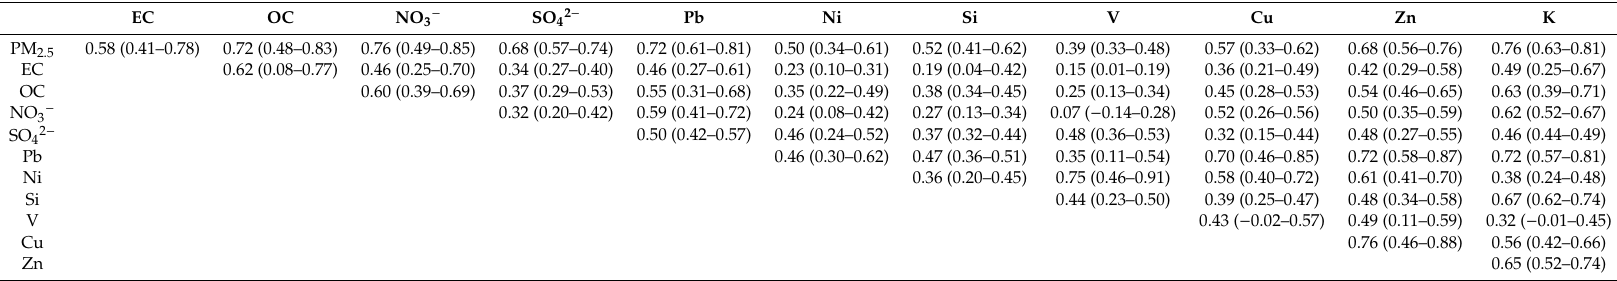
Table 2. Medians and ranges of correlation coe ffi cients of pairs of PM 2.5 and 11 PM 2.5 chemical components across six South Korean major cities from 2013 to